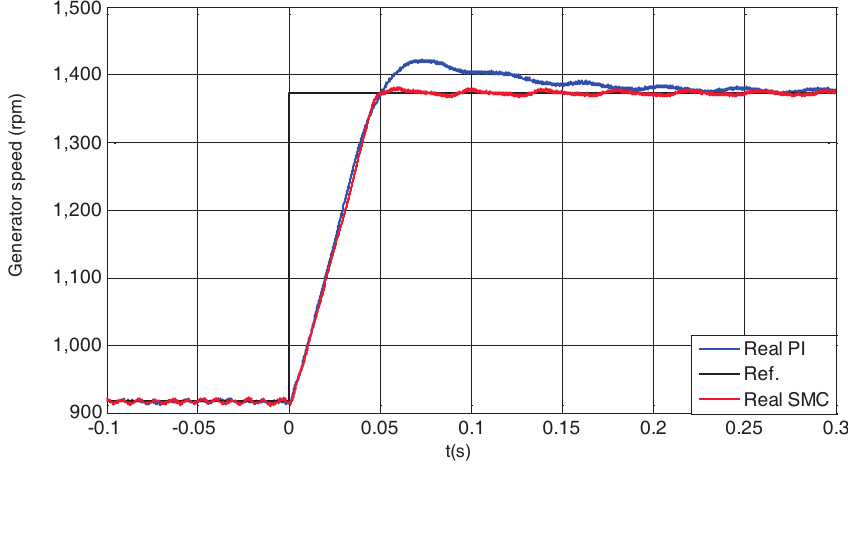
Figure 15. Rotor speed regulation using the traditional PID